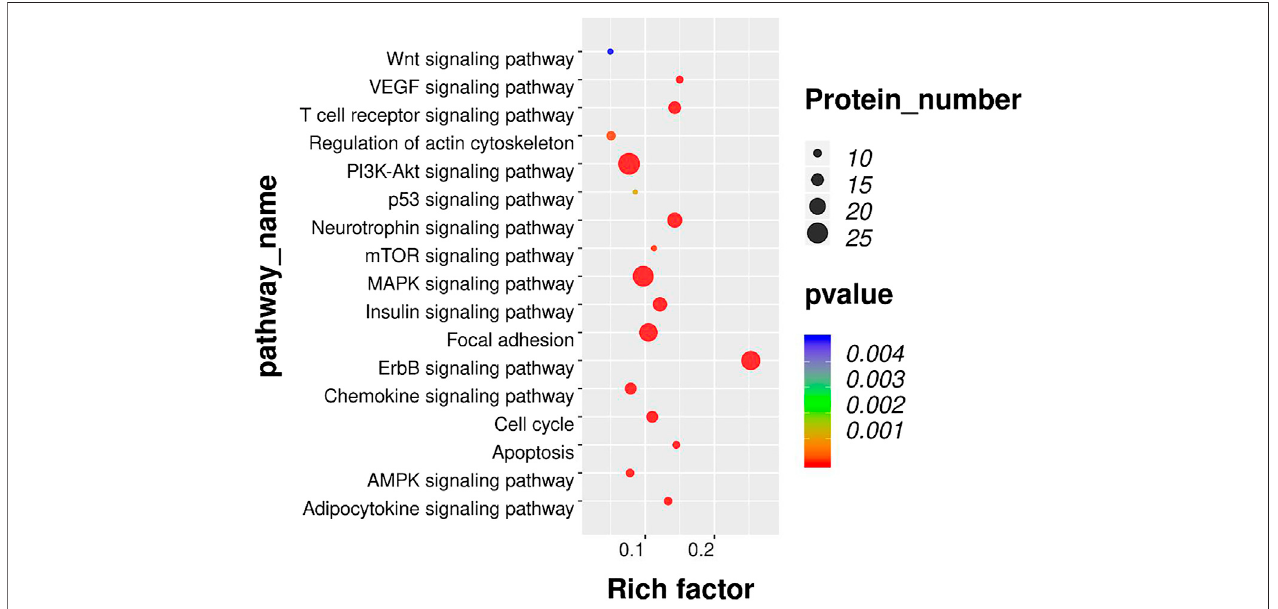
FIGURE 5 | KEGG pathway analysis of DEPs co-regulated by both BCP modeling and EA treatment in rat DRGs. Bubble plots showing the signi fi cant KEGG pathwaysforDEPswithoppositemodulatingtrendintheBCPandBCP+EAgroups.Thecolorofeachbubblerepresentssigni fi cance( p -value),andthevolumeofeach bubble represents protein number. KEGG: Kyoto Encyclopedia of Genes and Genomes; DEPs: differentially expressed phosphorylated